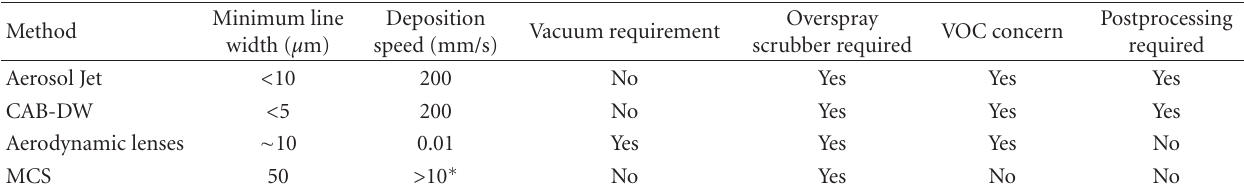
Table 1: Summary of A-DW technology print system